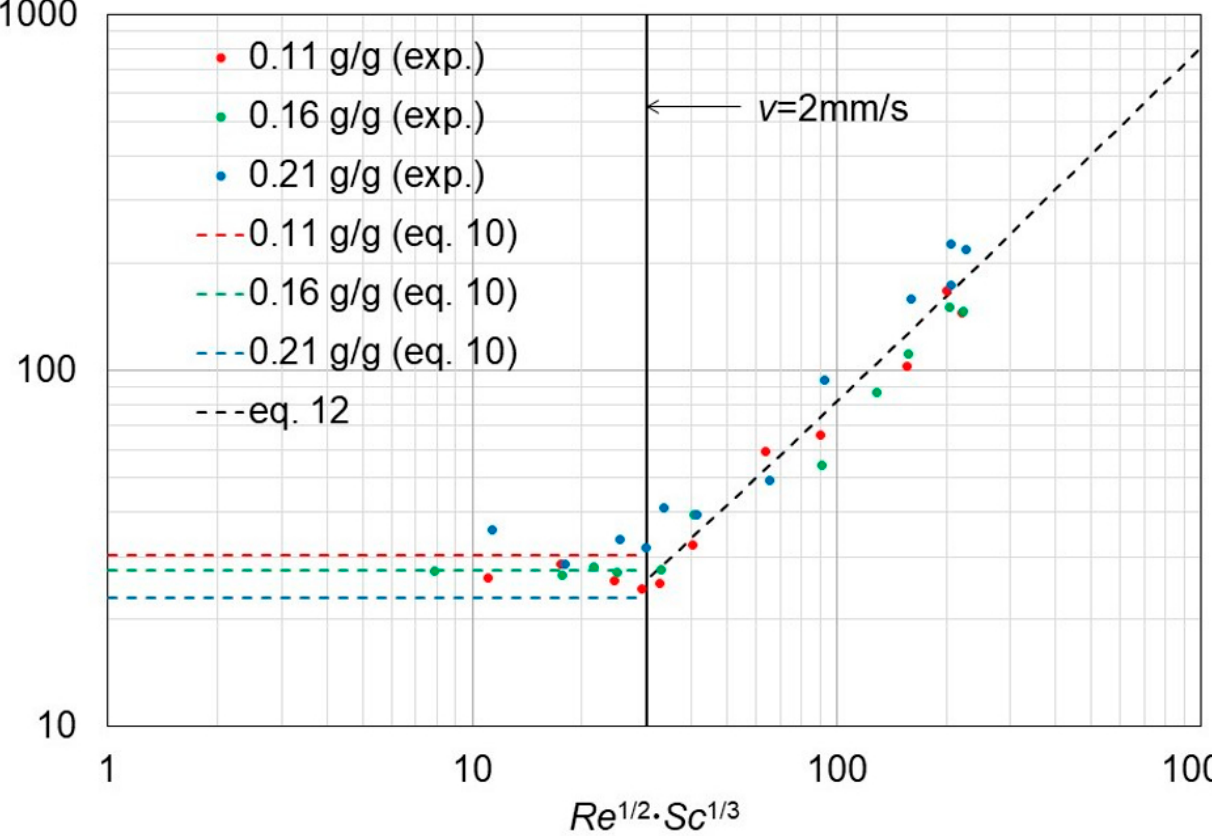
Figure 10. Plot of Sh against Re 1/2 · Sc 1/3 . The dashed horizontal lines for Re < 30 (v < 2 mm/s) show Sh , calculated from Equation (10) for the three investigated concentrations. The dashed black line represents the fit curve for Re > 30, given by Equation (12).